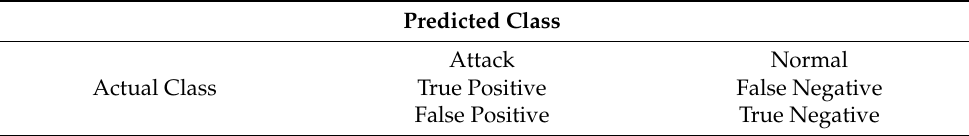
Table 3. The attributes of a confusion